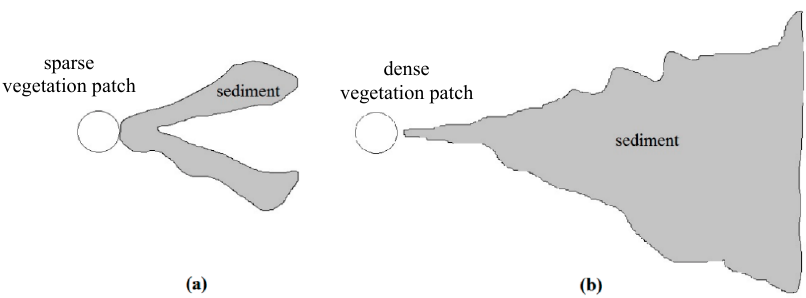
Figure 1. Schematic drawing for ( a ) open bed formation, ( b ) closed bed formation.